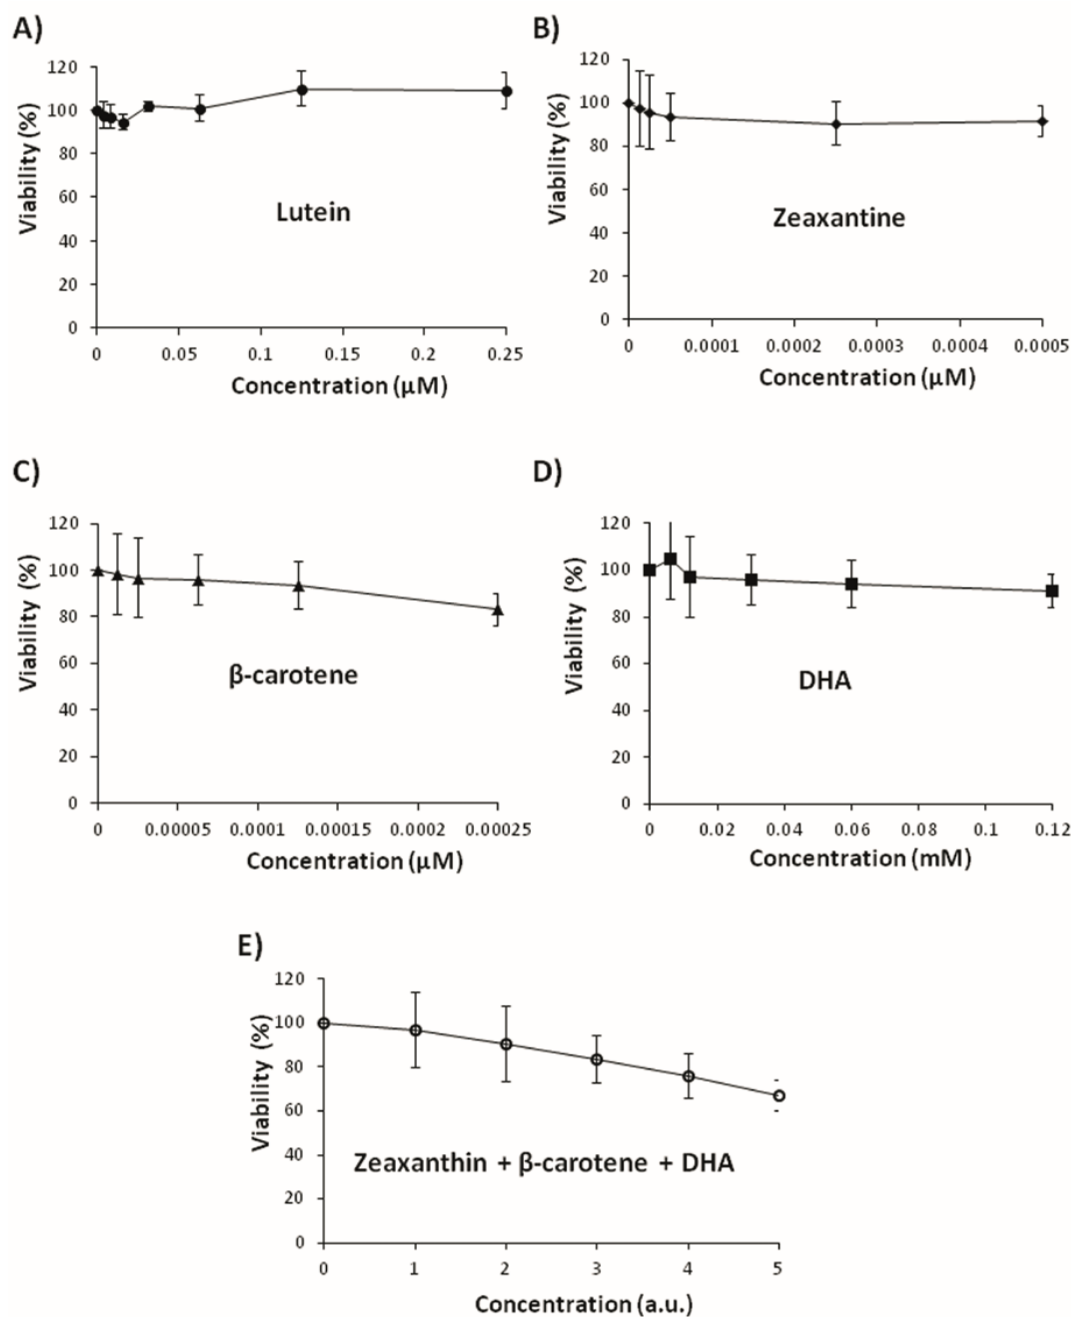
Figure 4. Effects of lutein ( A ), zeaxanthin ( B ), β -carotene ( C ), dehydroascorbic acid (DHA) ( D ) and a mix of compounds (zeaxanthin, β -carotene and DHA) ( E ) on viability of HL60 cells. Cell viability was assessed after 72 h by trypan blue exclusion test assay. The data are expressed as percentage with respect to control (mean ± SD from three independent experiments). a.u.: arbitrary units